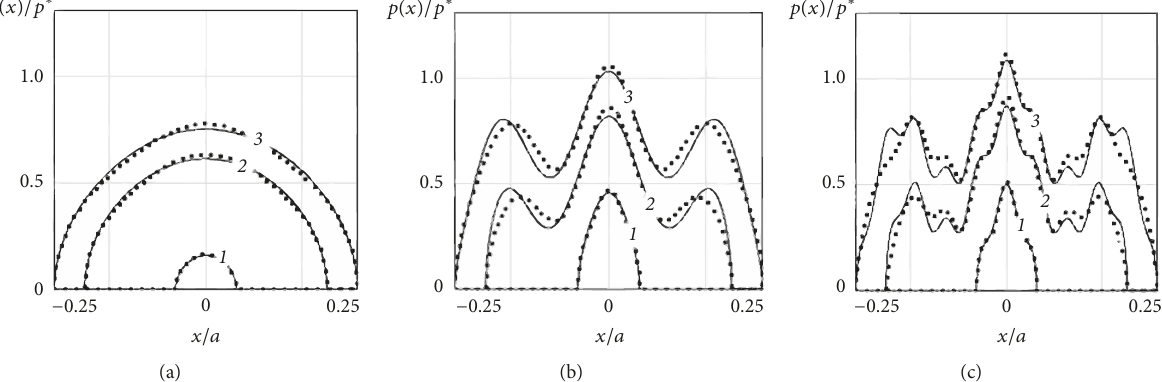
Figure 3: Evolution of contact pressure distribution for a nonperiodic wavy indenter ( 𝜆 1 = 2 𝜋 , Δ 1 = 0.5): f ( x ) = Δ 1 cos (𝑥) (a); f ( x ) = (𝑥) +0.02 Δ (11𝑥) (b); f ( x ) = Δ Δ 1 cos 1 cos